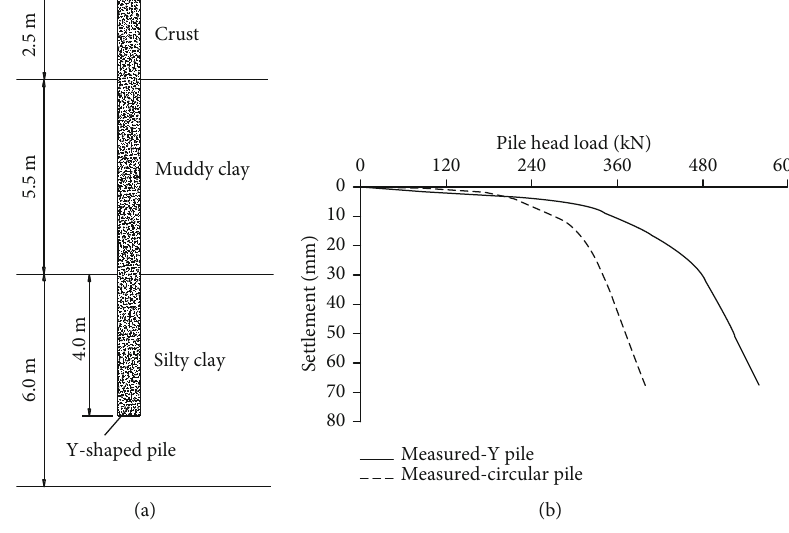
Figure 6: Field case: (a) pile and subsoil pro fi le; (b) fi eld load tests.